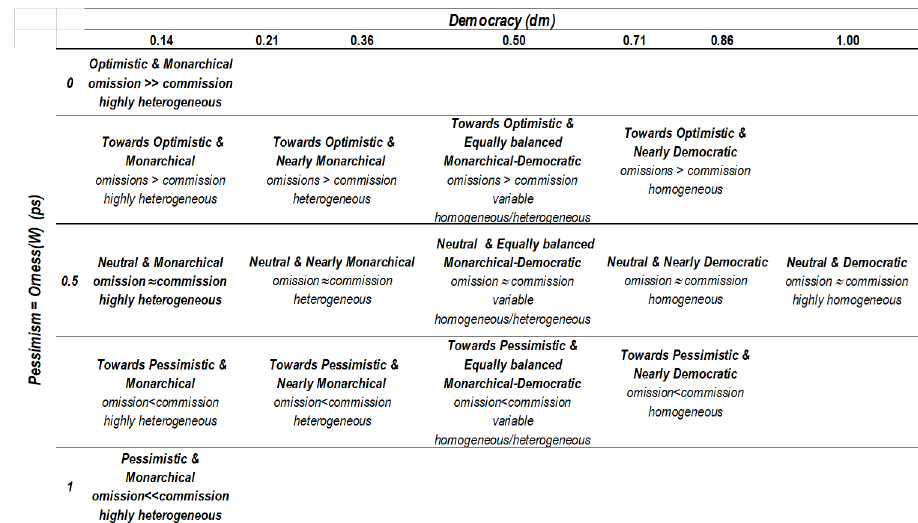
Figure 3. Semantics of the fusion of N = 7 contributing factors of burned areas defined by OWA operators with distinct degrees of pessimism ( ps ) in [0, 1] and democracy ( dm ) in {1/ N , 2/ N , .-.. N / N